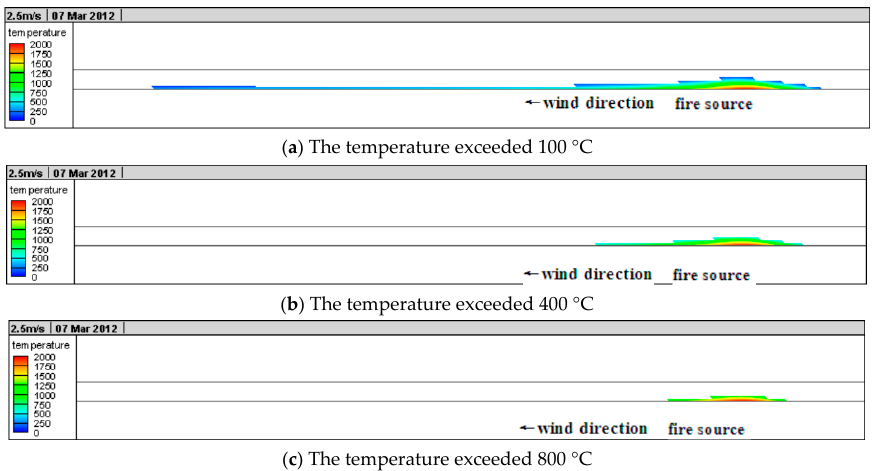
Figure 13. Longitudinal temperature in the